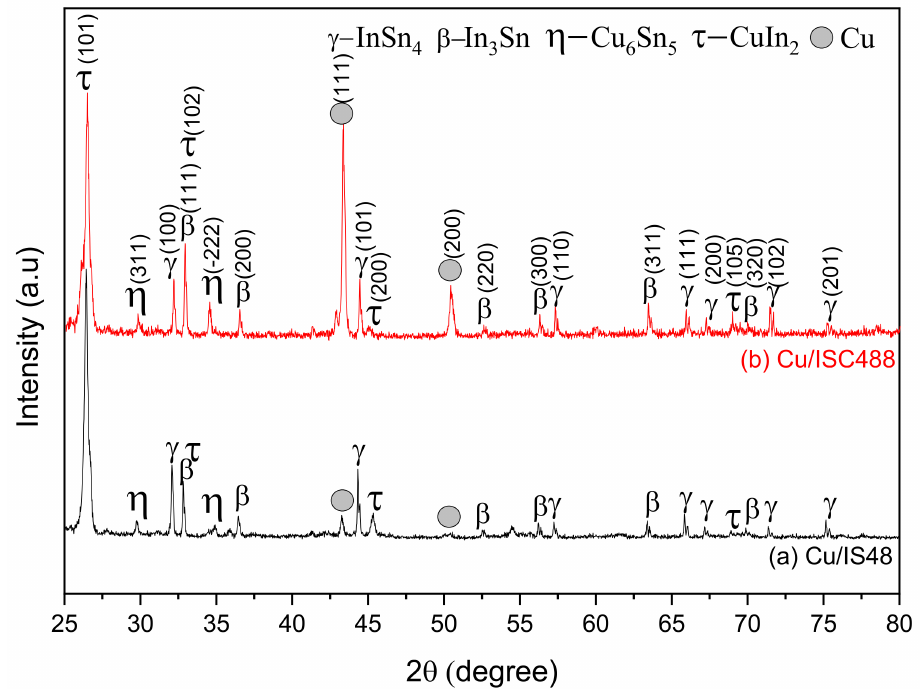
Figure 5. XRD patterns of the ( a ) IS48/Cu and ( b ) ISC488/Cu